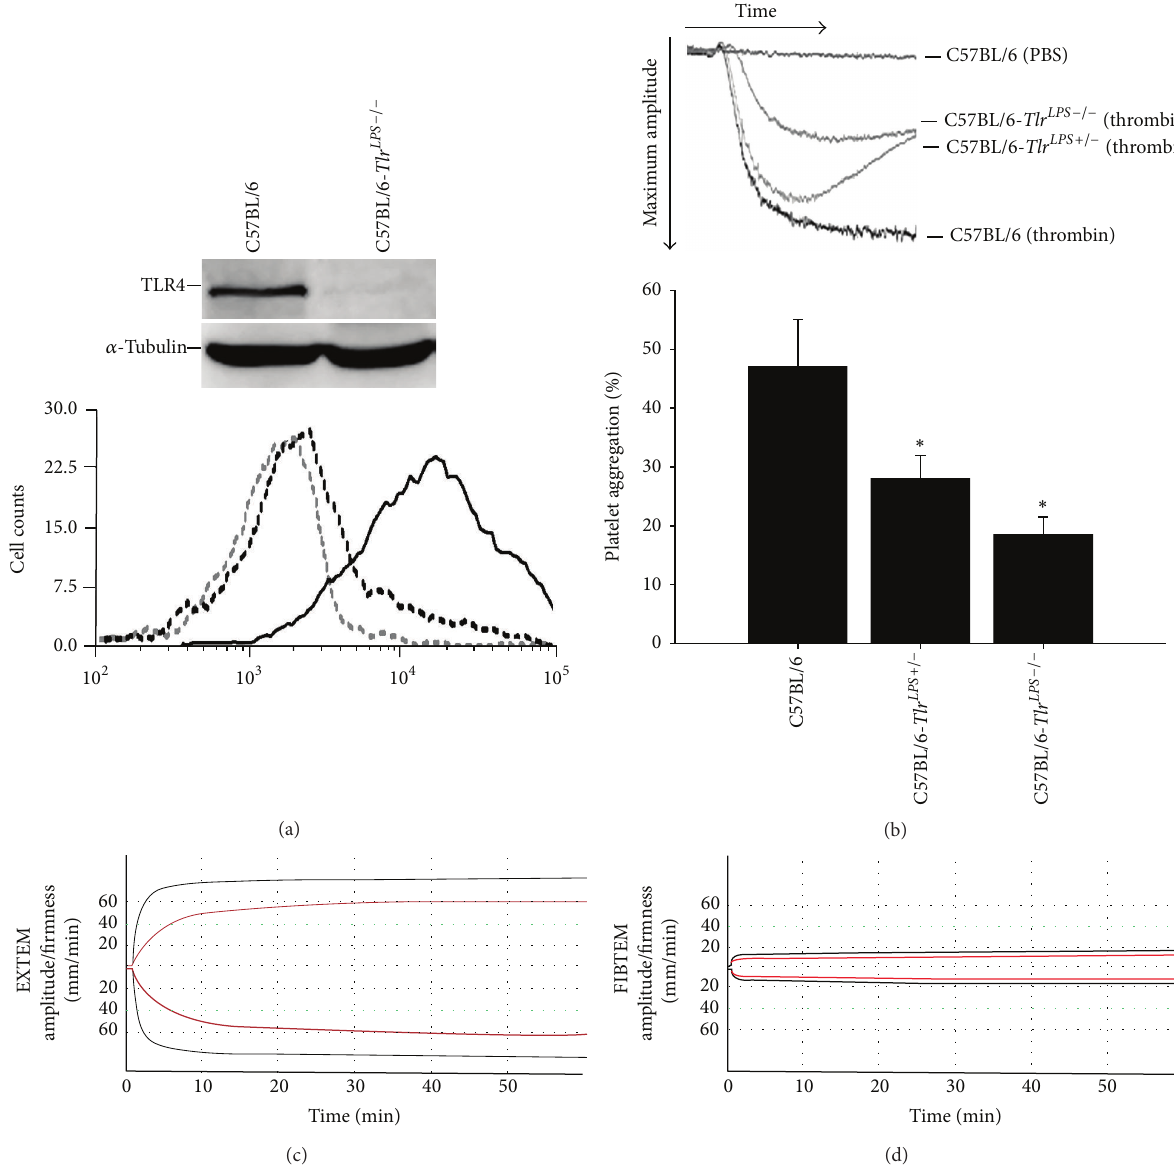
Figure 2: Platelet TLR4 is associated with platelet function in C57BL/6 mice. (a) TLR4 protein expression on the surface of platelets in C57BL/6 and C57BL/6- Tlr 𝐿𝑃𝑆−/− mice was analyzed by western blot analysis (upper graph) and flow cytometry (button graph). Negative control analyses were performed in the absence of specific PE-conjugated anti-TLR4 antibody (gray outline-hollow graph). C57BL/6 mice (black graph), but not C57BL/6- Tlr 𝐿𝑃𝑆−/− mice (black outline-hollow graph), express TLR4 protein in platelets. (b) Platelet aggregation was analyzed using aggregometry. The upper graph shows C57BL/6, C57BL/6- Tlr 𝐿𝑃𝑆−/− , and C57BL/6- Tlr 𝐿𝑃𝑆−/− mouse platelets with 0.1U/mL thrombin or PBS treatment. The data at the bottom illustrate the mean ± SD ( 𝑛 = 6 ). ∗ 𝑃 < 0.05 indicates a significant difference compared with the C57BL/6 group. (c and d) ROTEM was performed. The thromboelastometry graph shows the curves of EXTEM (c) and FIBTEM (d) in C57BL/6 (black line) and C57BL/6- Tlr 𝐿𝑃𝑆−/− (red line)